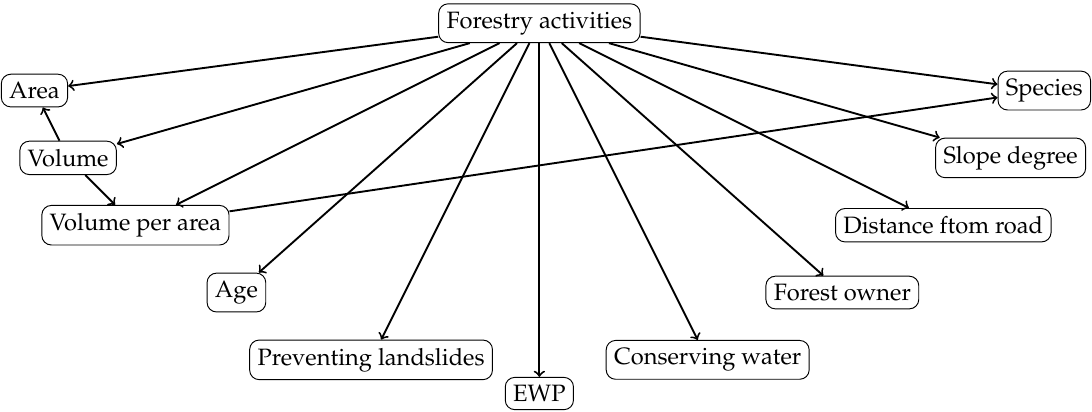
Figure 5. Structure of the Bayesian network model to estimate the probability of forestry activities.